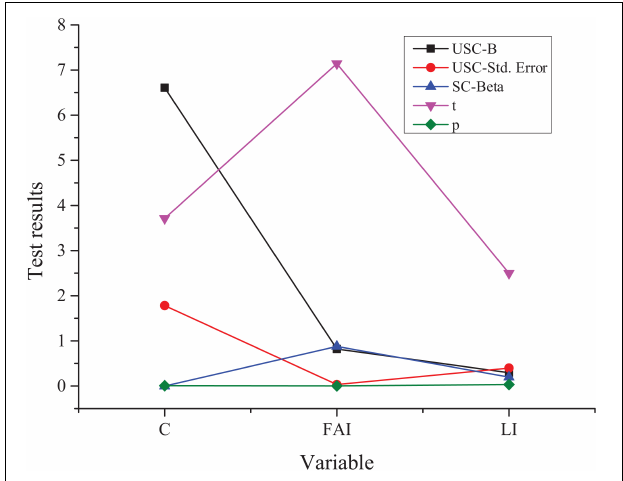
FIGURE 7 | Test results based on the Solow model. C, constant term; FAI, the input of fixed assets; LI, labor input; USC, the non-standard coefficient; SC, standard coefficient.